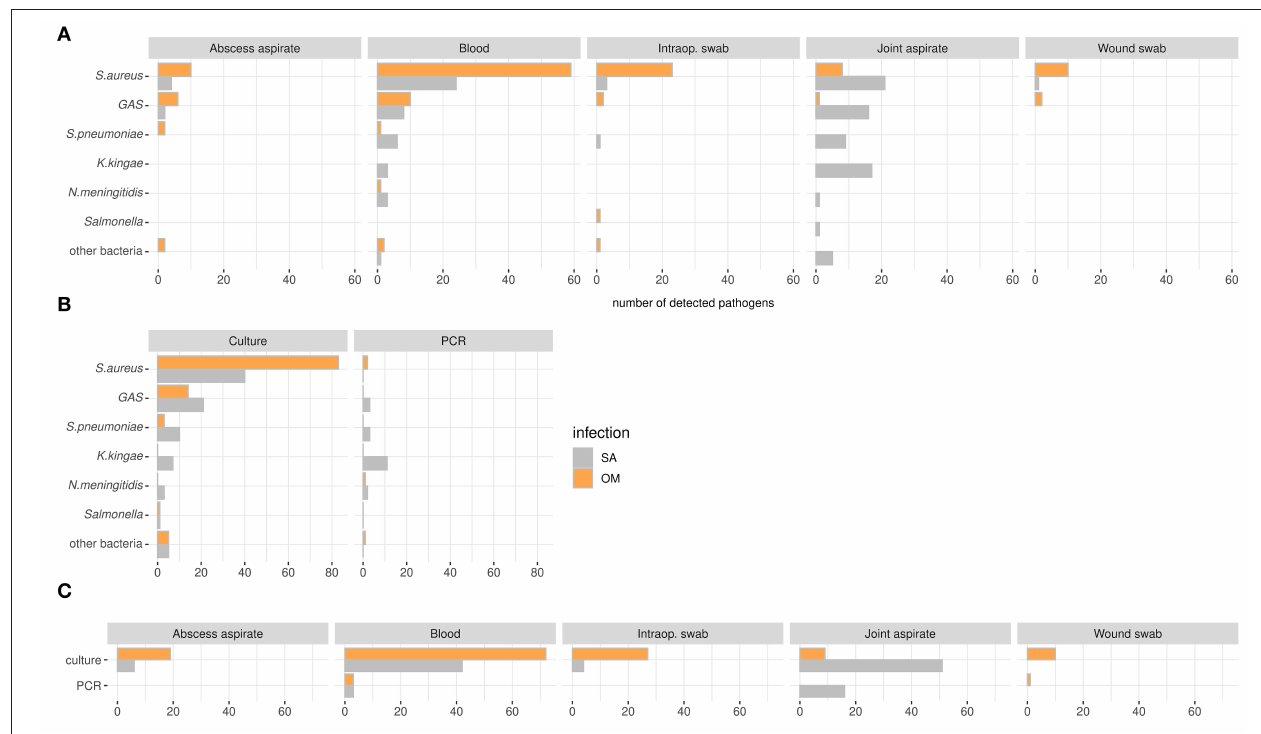
FIGURE 4 | Pathogens displayed according to detection media (A) and -methods (B) and the methods according to biological samples (C) in the OAIs cohort. (A) Biological samples that are not shown (n): bone biopsies ( n = 4), cerebrospinal fluid ( n = 1), endotracheal tube aspirate ( n = 2), and nose/throat swab ( n = 2). (B) and (C) samples with unknown methods ( n ): 23. Patients with OM + SA are not